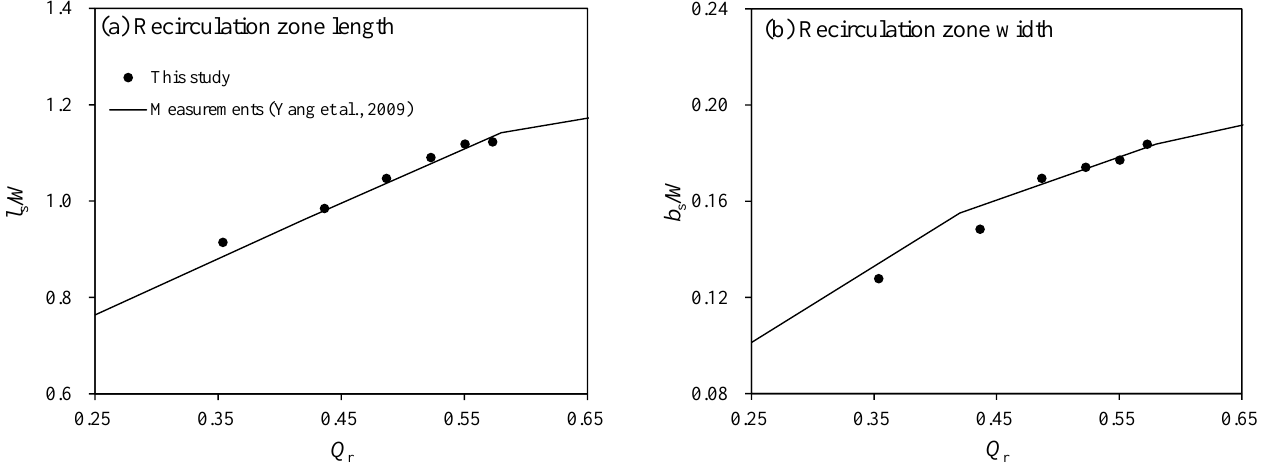
Figure 4. Validations of the recirculation zone size for the 90-degree confluence angle according to the discharge ratio [28].